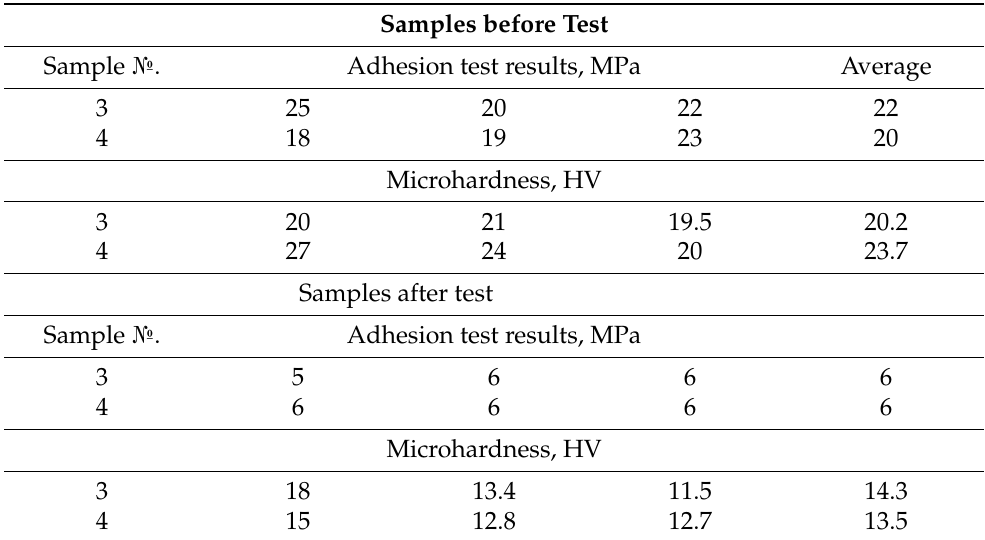
Table 5. Results of pull-off test after autoclave decompression test.